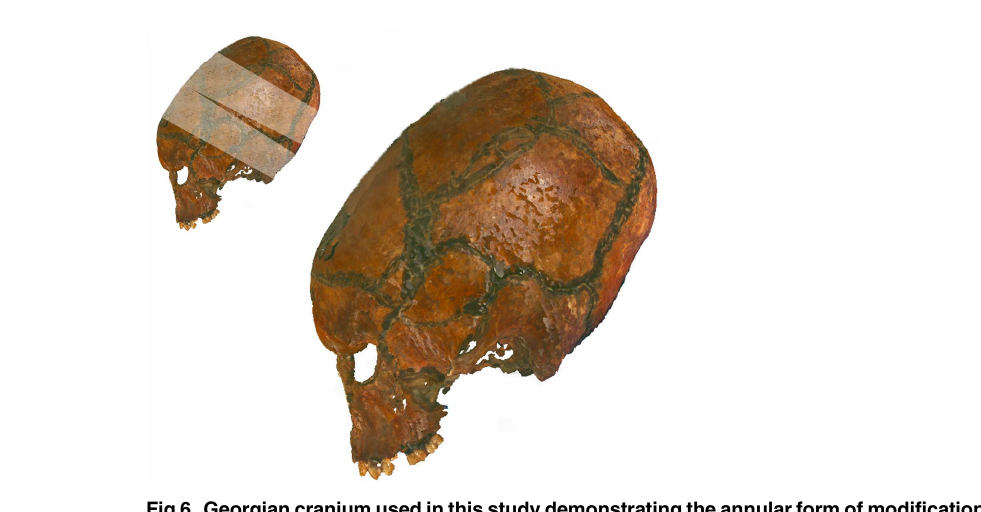
used in the eigenshapeanalysisin this study.